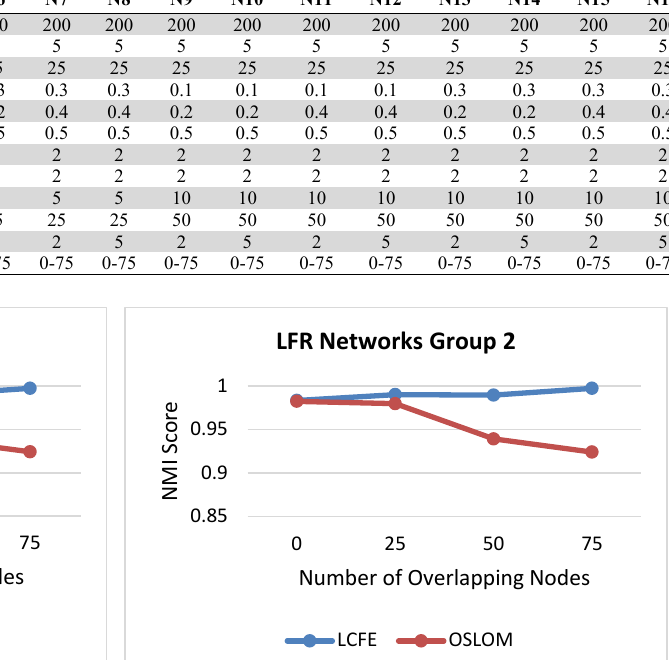
Fig. 3. NMI score comparison for LCFE and OSLOM for first group of LFR Networks with number of overlapping nodes ranging from 0 to 75